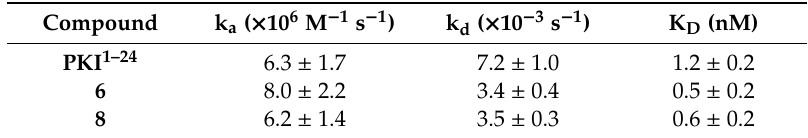
Figure 3. Binding interaction studies by Surface Plasmon Resonance (SPR): ( a ) Binding measurements of the non-modified PKI 1–24 control; ( b ) Binding measurements of Compound 6 ; and ( c ) Binding measurements of Compound 8 . Compounds 6 and 8 demonstrated K D values of 500 and 600 pM, respectively and demonstrate slightly slower dissociation rates as compared to the non-modified PKI 1–24 control. Table 2. Summary of SPR analysis. Values were obtained from at least three independent measurements and are given with SD.